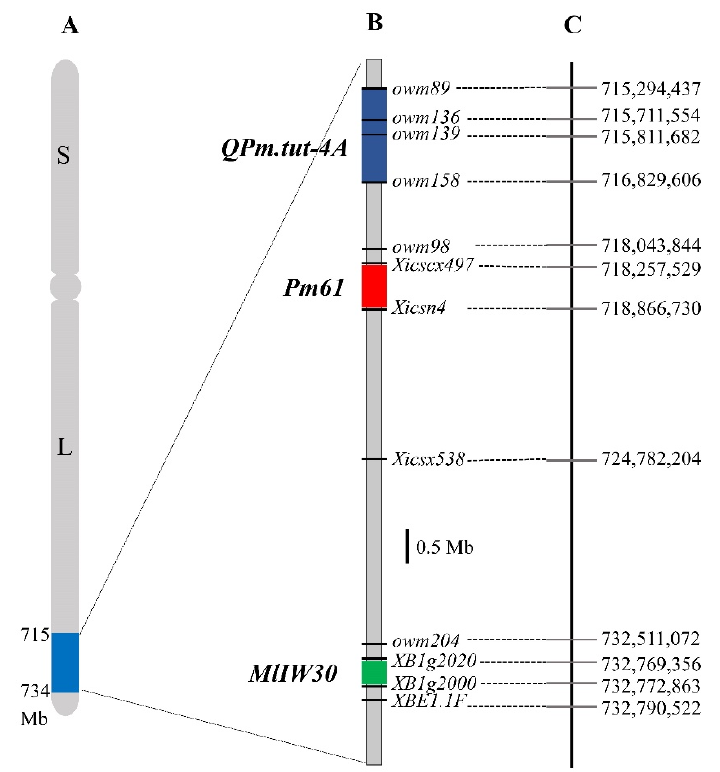
Figure 7. A sketch physical map of chromosome 4A ( A ), comparative analysis of the three Pm genes or QTL on chromosome arm 4AL ( B ), and corresponding physical locations in chromosome 4AL in the Chinese Spring reference genome ( C ).